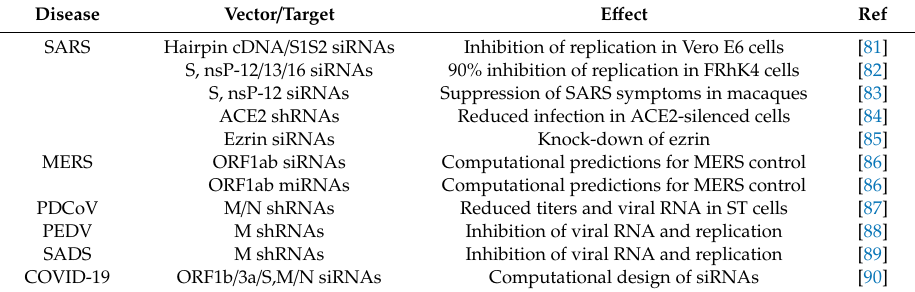
Table 3. Examples of RNAi-based gene silencing against Coronaviruses.